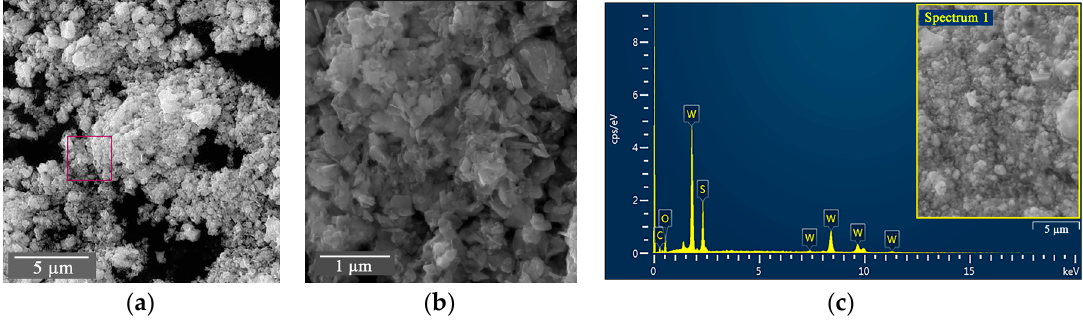
Figure 17. ( a , b ) SEM images and ( c ) EDX spectrum for commercial WS 2 .